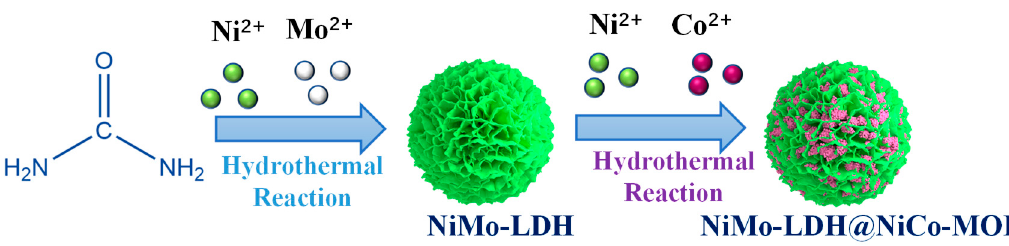
Figure 1. Schematic diagram of the synthesis method for